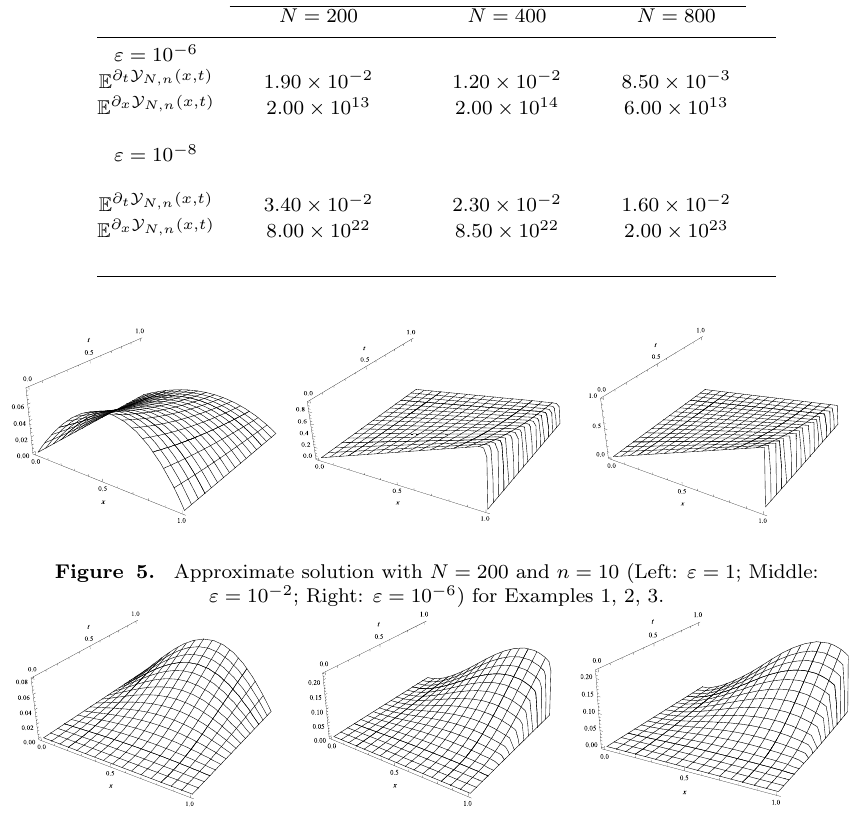
Figure 6. Approximate solution with N = 200 (Left: ε = 1; Middle: ε = 10 − 2 ; Right: ε = 10 − 6 ) for Example 4.